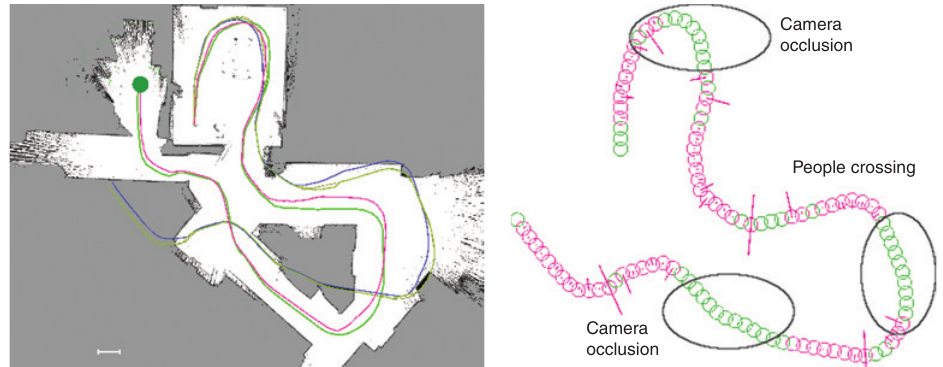
Figure 15. Example of Vision-Based Path Following with Camera Occlusions or People Crossing Just in Front of the Robot.